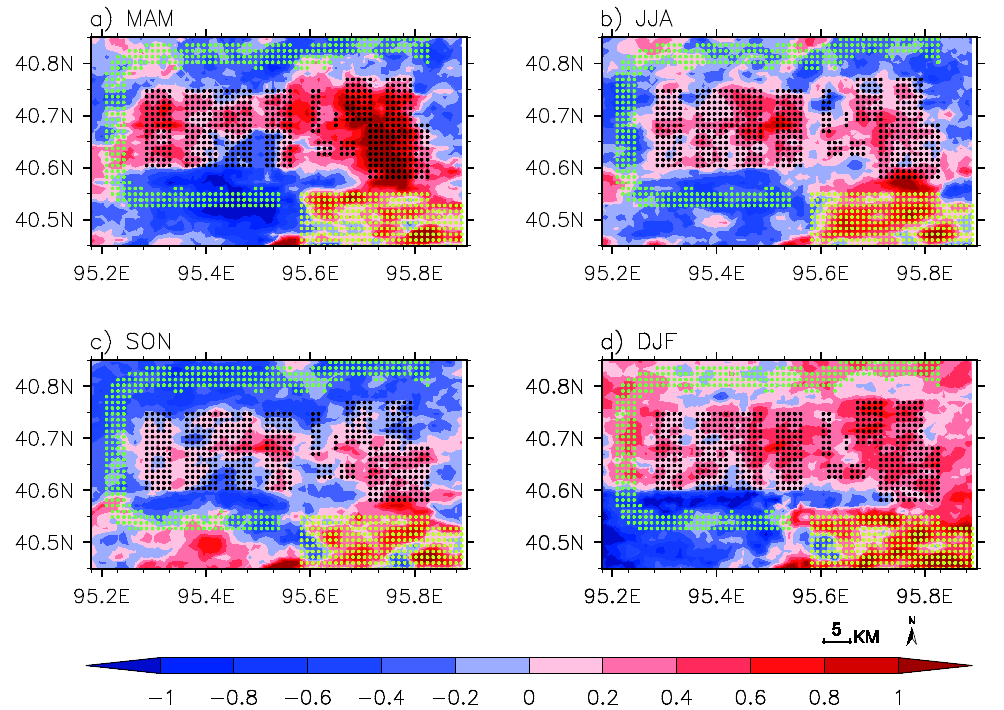
Figure 5. The same as Figure 4 but for the difference between the two individual years, 2012 minus 2005 in ( a ) spring; ( b ) summer; ( c ) autumn; and ( d ) winter.